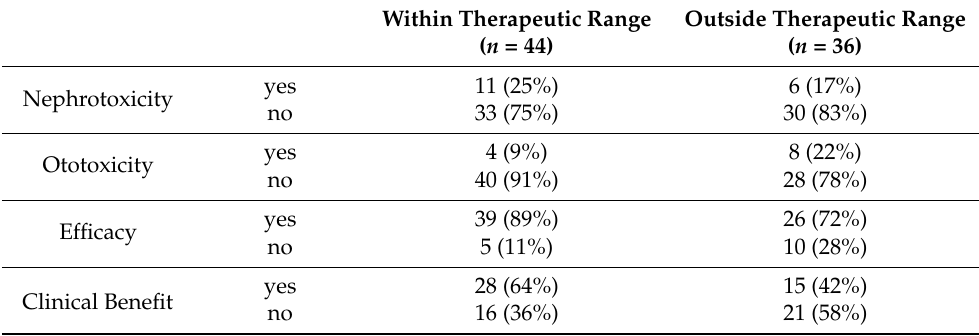
Table 3. Number and proportion of patients with toxicity, therapeutic response, or therapeutic success (efficacy without toxicity) according to Cmax